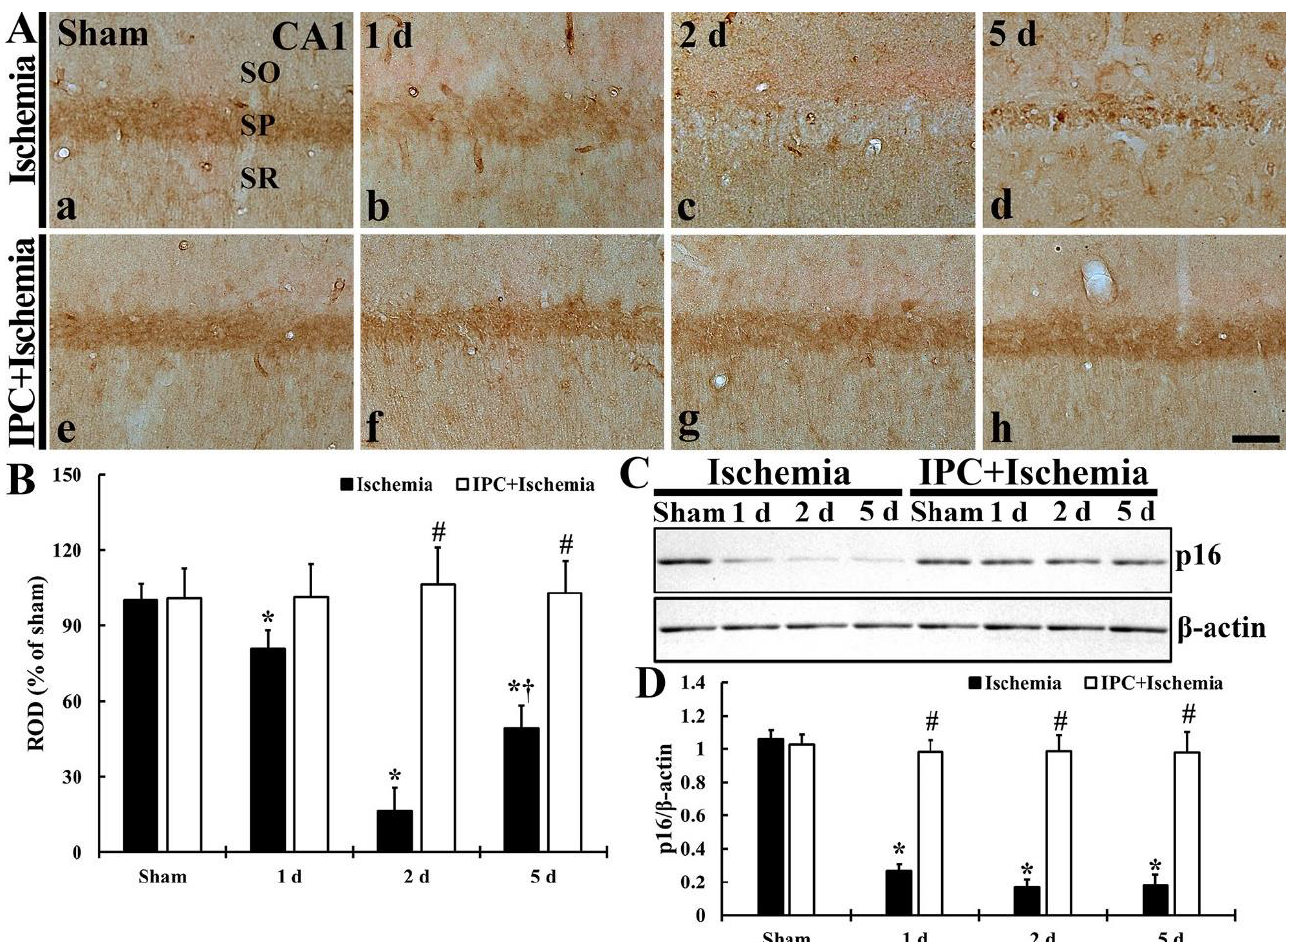
Figure 6. ( A ) Immunostaining of p16 INK4a in CA1 of the TI (upper column) and IPC+TI (lower column) groups at sham (a,e), 1 day (b,f), 2 days (c,g), and 5 days (d,h) after TI. p16 INK4a immunoreactivity in the pyramidal cells is gradually decreased after TI. In the IPC+TI group, however, p16 INK4a immunoreactivity in the pyramidal cells is well preserved after TI. Scale bar = 50 µ m. ( B ) ROD graph of p16 INK4a immunoreactivity in pyramidal cells. ROD was calibrated as percent (sham group, 100%). The bars represent means ± SD ( n = 7, * p < 0.05 versus sham; # p < 0.05 versus TI group; † p < 0.05 versus prior time point of each group). ( C ) Western blot of p16 INK4a (16 kDa) in CA1 of the TI and IPC+TI group at sham, 1 day, 2 days and 5 days after TI. β -actin was used as a protein loading control. ( D ) Relative band intensity of p16 INK4a level. p16 INK4a level is well preserved in the IPC+TI group. The bars represent means ± SD ( n = 7, * p < 0.05 versus sham; # p < 0.05 versus TI